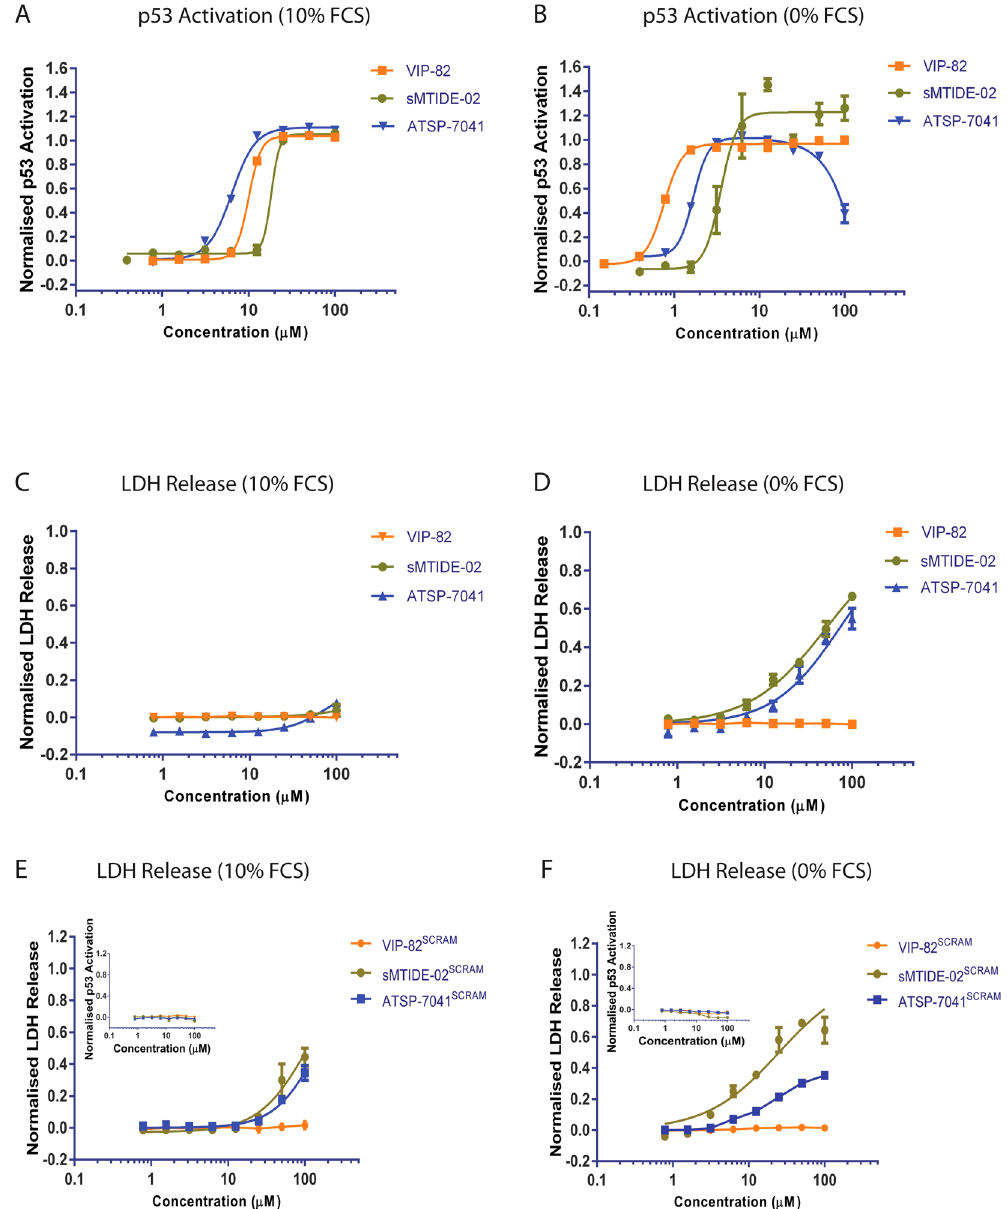
Figure 2. sMTIDE-02, ATSP-7041 and VIP-82 were titrated on to T22 p53 reporter cells and p53 transcriptional activation assessed ( A ) in the presence (10% FCS) or ( B ) absence of serum. ( C and D ) Identical titrations were performed on T22 cells and LDH release measured. Scrambled variants of sMTIDE-02, ATSP- 7041 and VIP-82 (designated with scram in superscript) were synthesized, where the residues involved in the conserved binding motif (F19, W23, L26) were interchanged with each other to abrogate binding to p53. sMTIDE-02 SCRAM , ATSP-7041 SCRAM and VIP-82 SCRAM were titrated on to p53 reporter T22 cells ( E ) in the presence (10%) and ( F ) absence of serum and assessed for p53 activation and LDH release. p53 activations profiles are shown in the